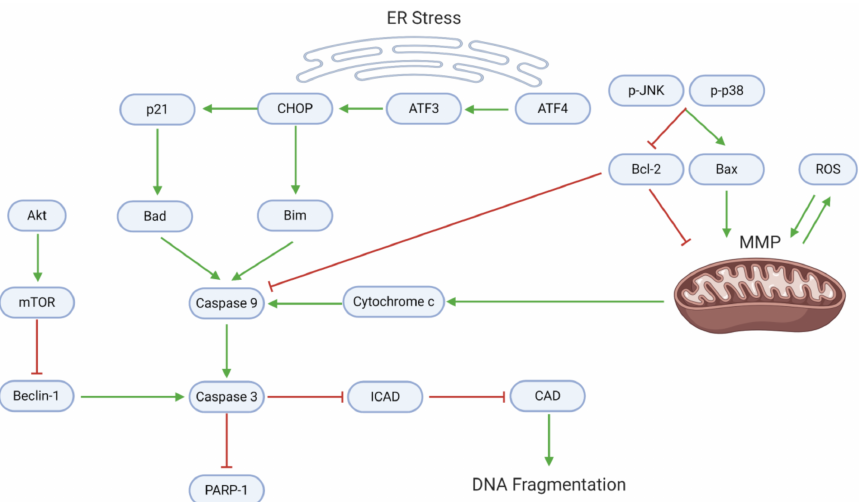
Figure 5. Proapoptotic mechanisms, which involve mitochondrial dysfunction, ER stress, and caspase activation, are suppressed in GBM. Dysregulation of mitochondrial homeostasis (often through oxidative imbalance) leads to the release of cytochrome c, a caspase activator. ER stress upregulates activating transcription factors; in turn, ATFs activate CHOP, p21, and proapoptotic proteins that enhance caspase activation. Active caspase 9 (along with Beclin-1) cleaves caspase 3, which enforces apoptosis and DNA fragmentation. In proliferating GBM cells, however, the anti-apoptotic protein Bcl-2 directly inhibits caspase 9, while mTOR inhibits